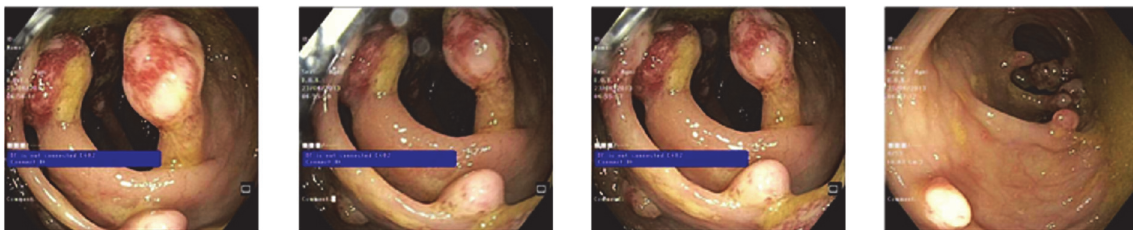
Figure 1: Multiple pedunculated and sessile, nonbleeding polyps were found in the entire colon more and larger in the right colon. They are > 80 in number with variable sizes (ranging from few millimeter to 3 cm).